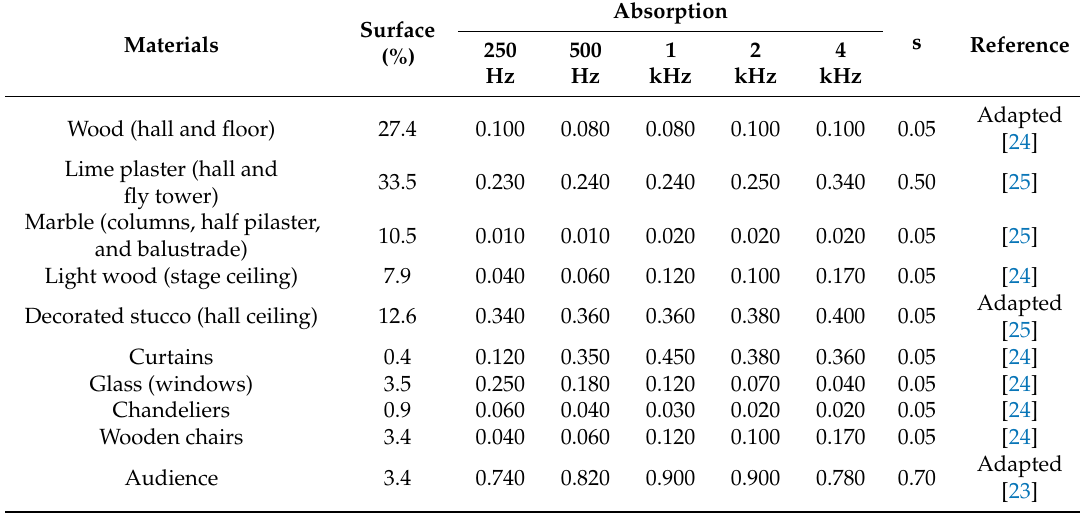
Table 1. Absorption and scattering coe ffi cients (s) for all the materials involved in the simulation. The scattering coe ffi cient is referred to 707